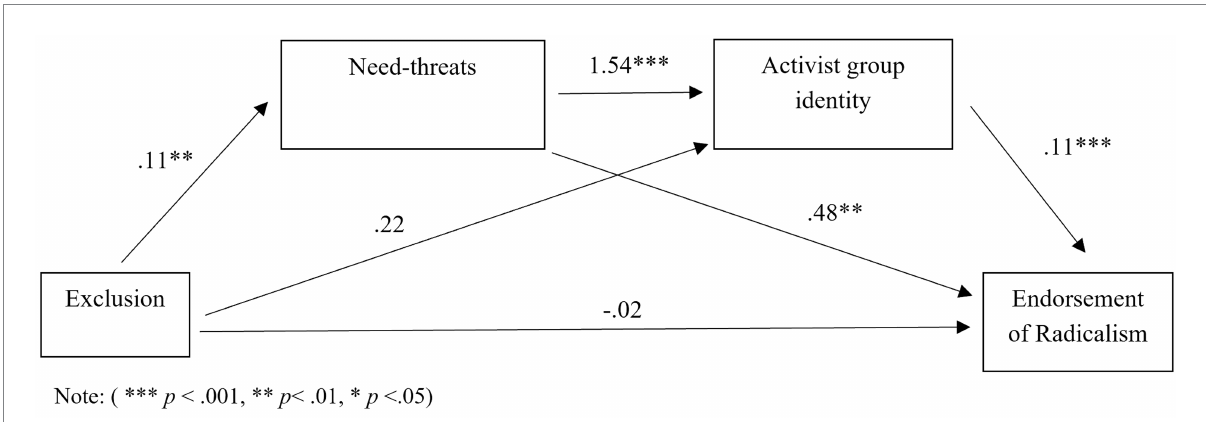
FIGURE 3 Serial mediation model with coefficients for pathway between exclusion and endorsement of radical actions with mediators need-threats and activist group